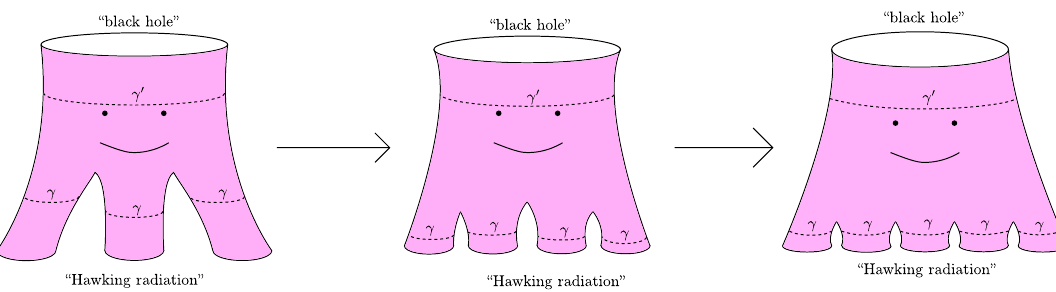
Figure 2 . Two steps of the \black hole evaporation" process for our (cid:12)rst model. The surfaces (cid:13) and (cid:13) 0 give two possible HRT surfaces homologous either to the \Hawking radiation" exits or the \black hole" exit. As the octopus grows more and more legs, the length of the \ankle bracelets" (cid:13) increases and the length of the \headband" (cid:13) 0 decreases: the crossover point where the headband becomes shorter is the \Page time" of the